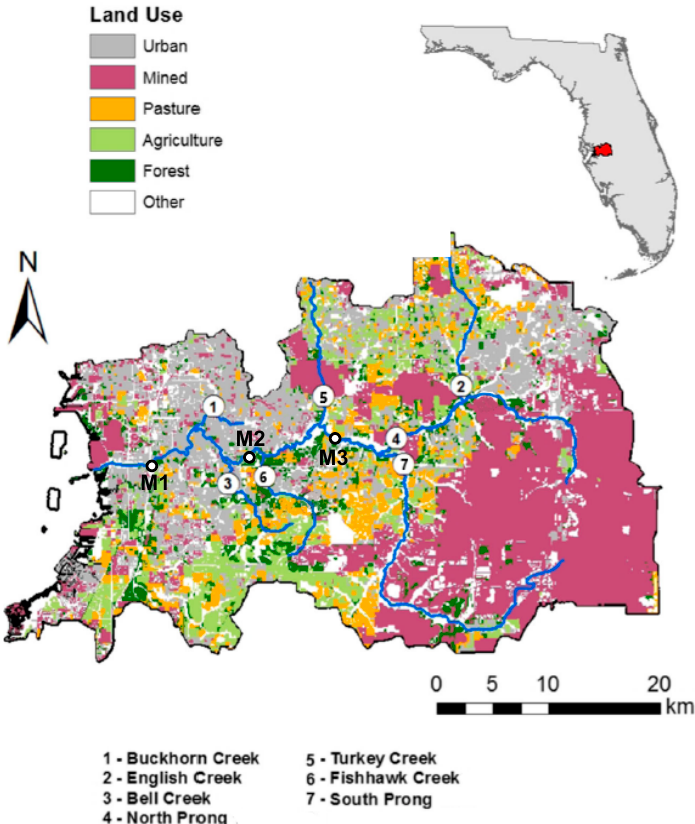
Figure 1. A location map showing different sub-basins of the Alafia River Watershed located in central Florida, United States. M1 refers to Alafia, M2 refers to Bell Shoals, and M3 refers to Lithia mainstem stations.